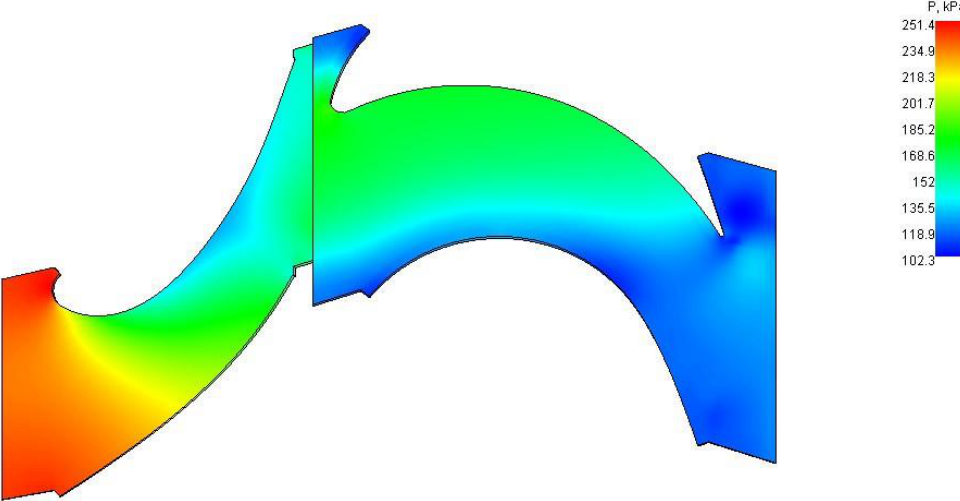
Figure 29. Pressure contours for the middle section of the rotor blade.